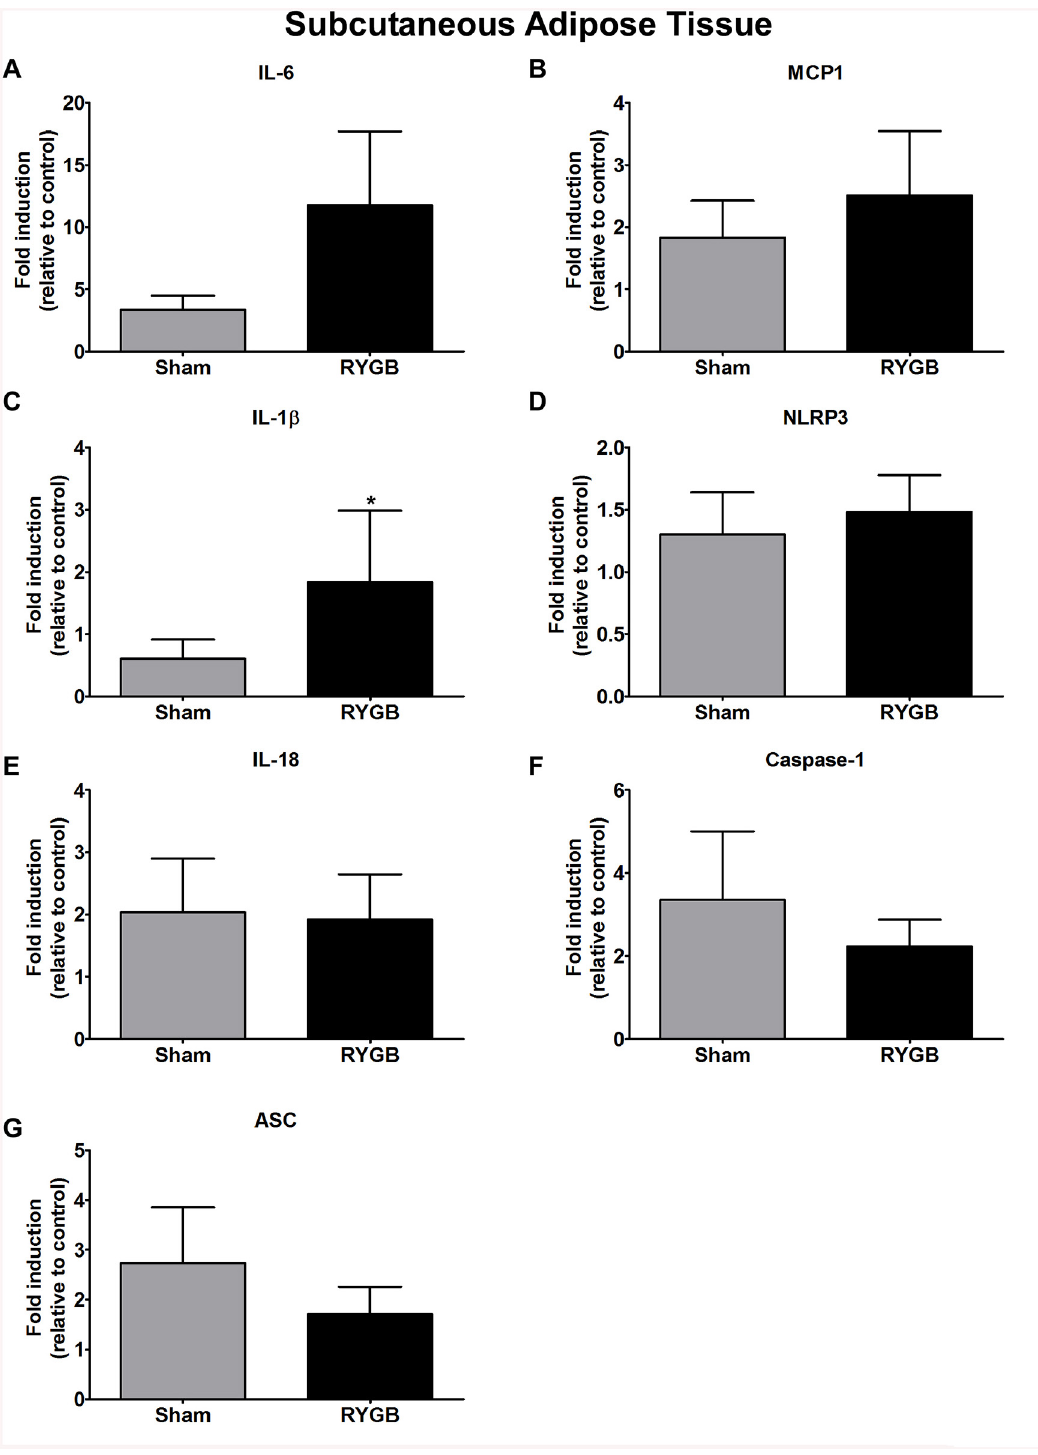
Fig 4. Differential gene response in subcutaneous adipose tissue. Differential gene response of IL – 6 (A), MCP – 1 (B), IL – 1 β (C), NLRP3 (D), IL – 18 (E), Caspase – 1 (F) and ASC (G) in subcutaneous adipose tissue between Sham control and RYGB groups. Data are mean ± SE (N = 8 for both control and RYGB groups), * denotes a significant difference between Sham control vs.